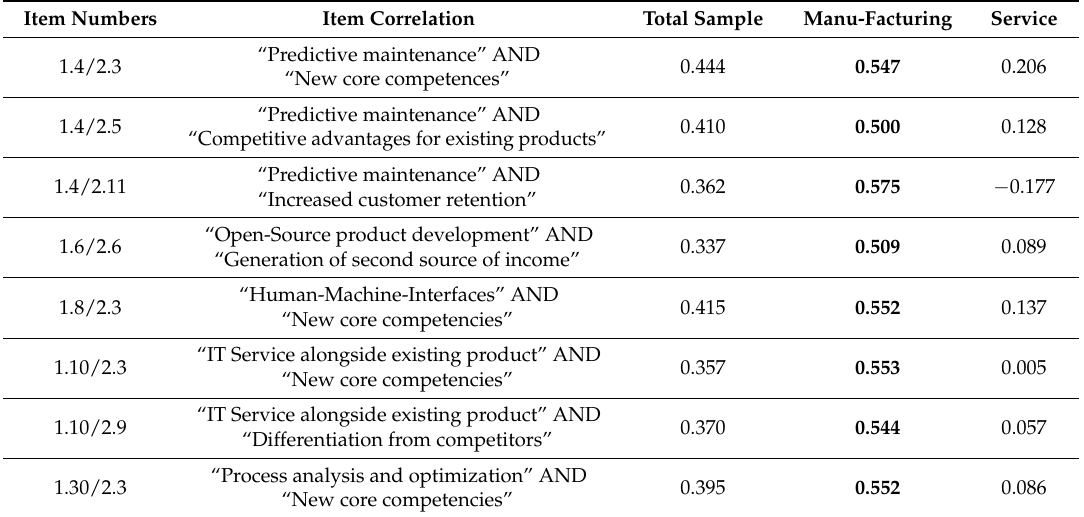
Table 2. Correlations between new business model features and potentials for the solution